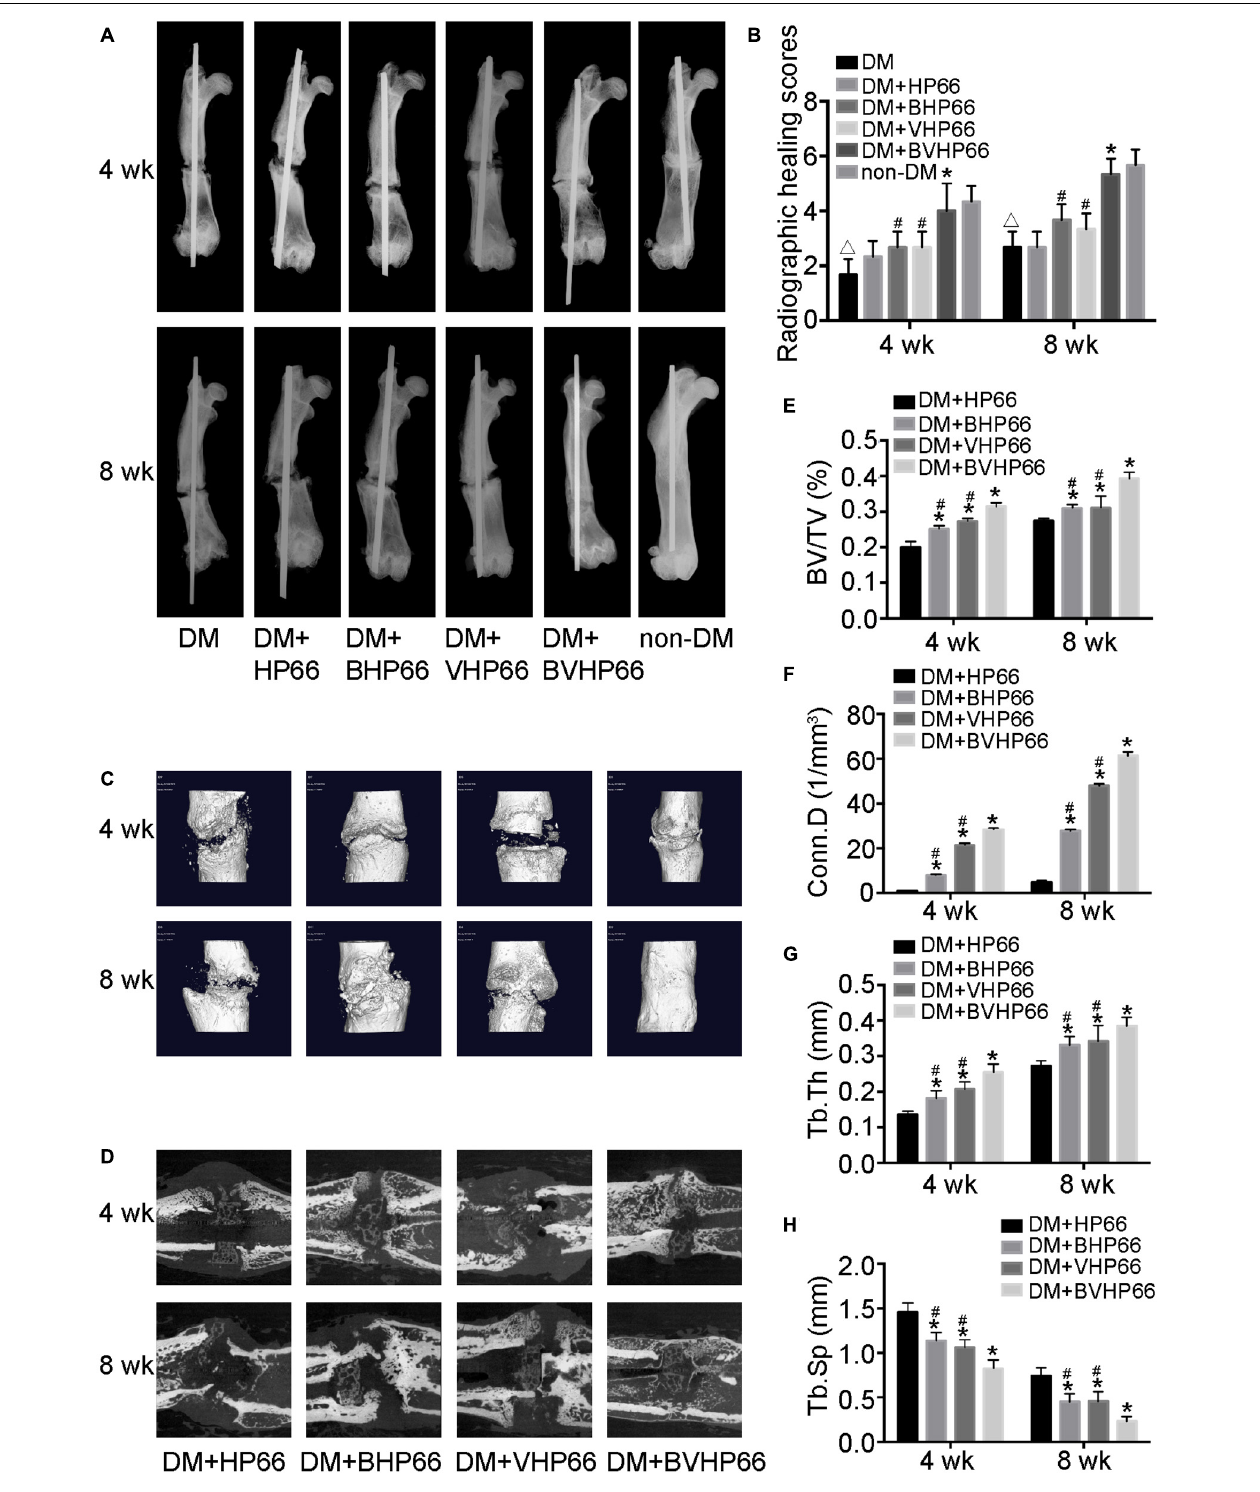
FIGURE 9 | X-ray and micro-CT analyses. (A) Representative radiographs and (B) radiographic healing scores of all the groups after 4 and 8 weeks. Representative (C) 3D and (D) 2D micro-CT images around the fracture site after 4 and 8 weeks in the DM + HP66, DM + BHP66, DM + VHP66, and DM + BVHP66 groups. The quantitative analysis of regenerated bone structure, including (E) BV/TV, (F) Conn.D, (G) Tb.Th, and (H) Tb.Sp. n = 3 for each group, data were expressed as mean ± SD. * P < 0.05, vs. HG + HP66 group; # P < 0.05, vs. HG + BVHP66 group; (cid:77) P < 0.05, vs. non-DM group.